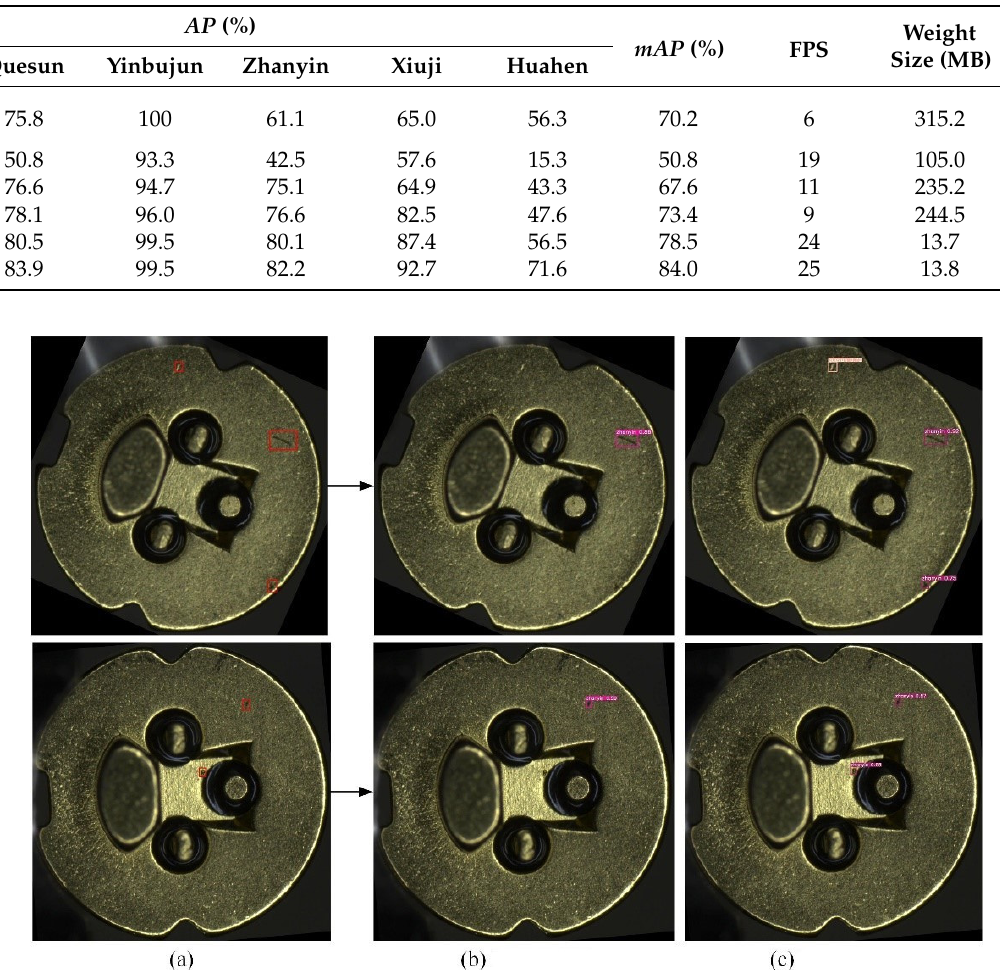
Figure 10. Examples of detection results from ( a ) original YOLO-V5 algorithm ( b ) YOLO-SO algorithm. Table 4. Result evaluation of different object detection models.